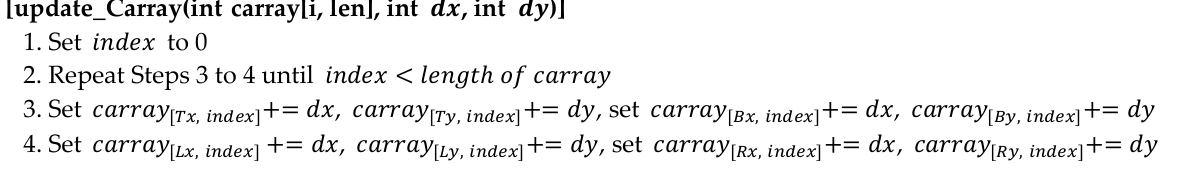
Figure 17. Proposed algorithm for updating the circular coordinate array.